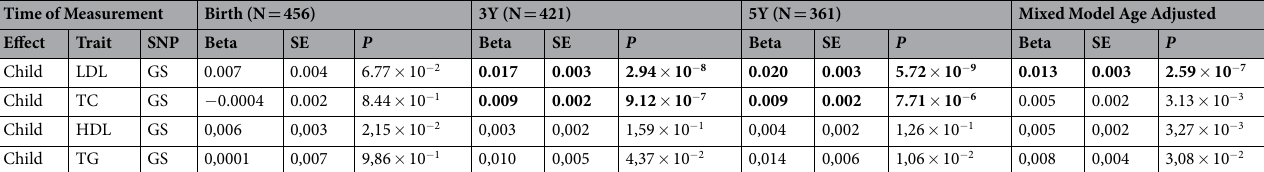
Table 2. Results for genotype score and lipids levels. Beta and SE at birth, 3 year and 5 year are natural logarithm of the lipid level trait in mg/dl. The unit of beta and SE after linear mixed model is natural logarithm of the lipid level trait in mg/dl per